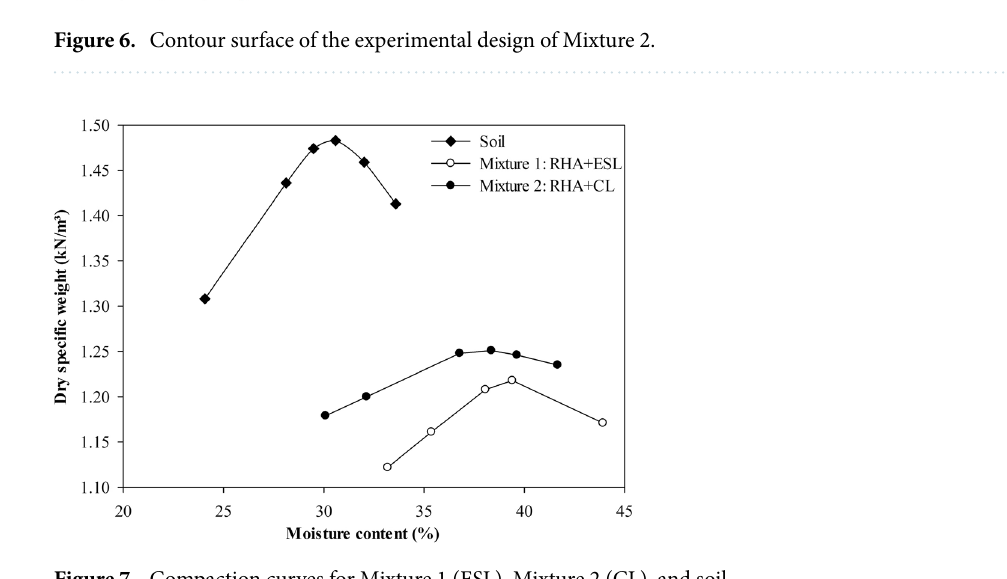
Figure 7. Compaction curves for Mixture 1 (ESL), Mixture 2 (CL), and